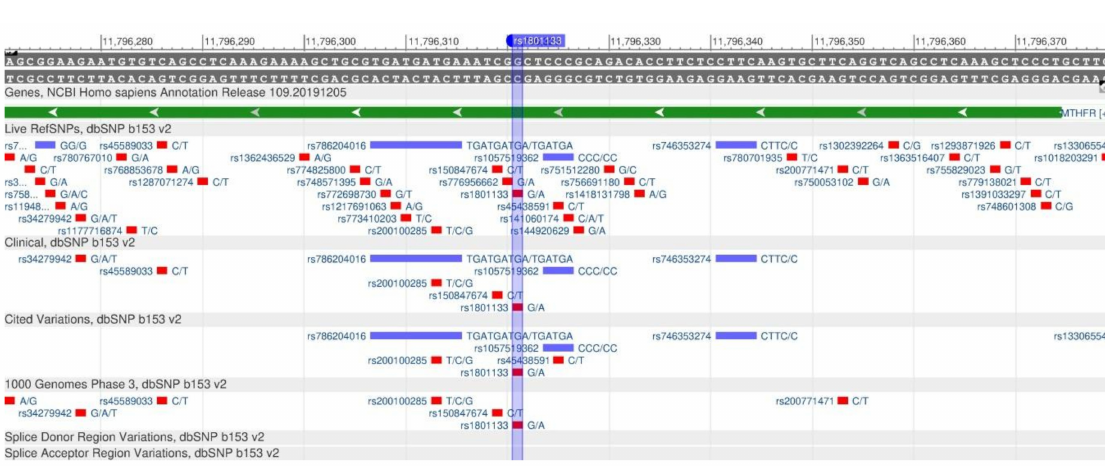
Figure 20. A portion of the MTHFR gene (located on the short (p) arm of chromosome 1) containing the oligonucleotide polymorphism